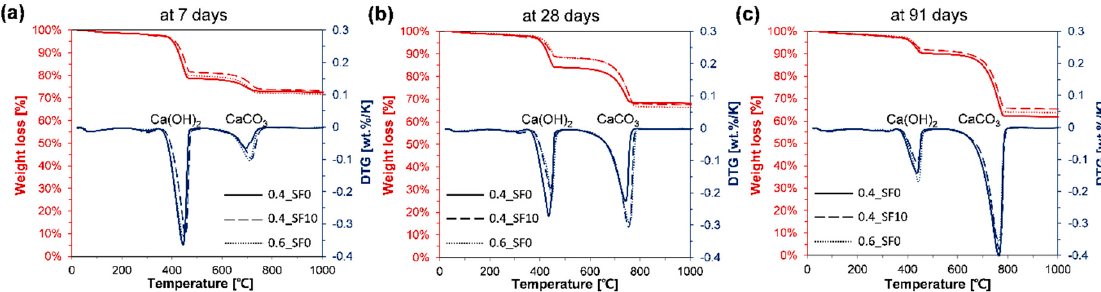
Figure 5. Results of thermogravimetric analysis at ( a ) 7 days, ( b ) 28 days, and ( c ) 91 days. Red and blue lines in each graph mean weight loss and derivative of weight loss as a function of temperature, respectively.